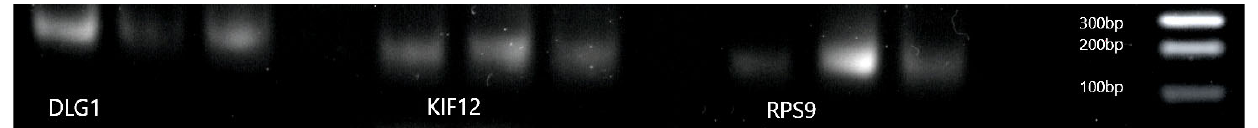
Figure 8. The Qrt ‐ PCR analysis of mRNA KIF12 in human fetal and postnatal kidneys and their calculated 2 −∆∆ Ct .